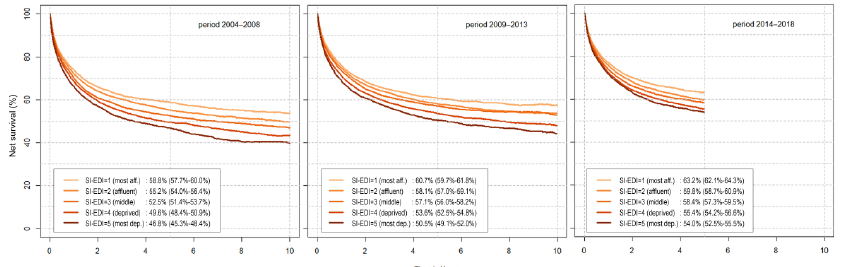
Figure 1. Net survival by Slovenian deprivation index (SI-EDI) with five-year survival and corre- sponding 95% confidence interval, by calendar period for both genders combined, Slovenia 2004−2018.